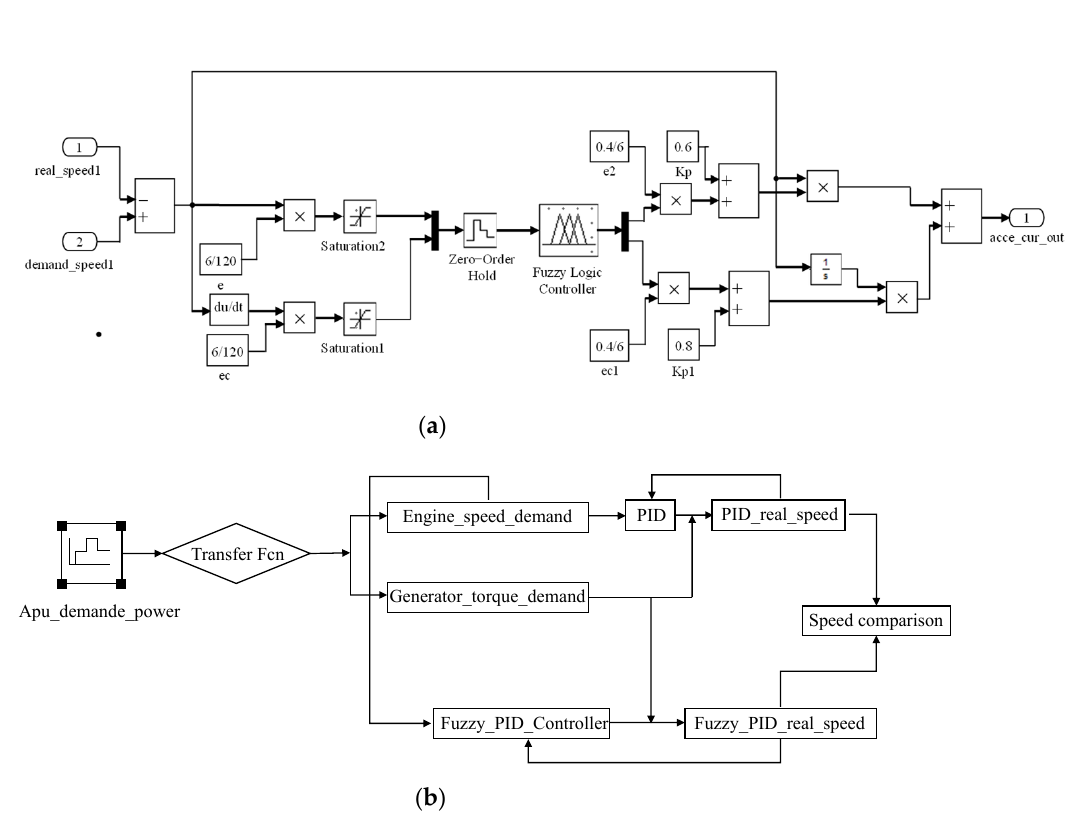
Figure 1. Schematic diagram of the simulation model: ( a ) The model of the Fuzzy_PID sub-system; ( b ) Simplified model for the comparison between the fuzzy PID controller and the PID controller.